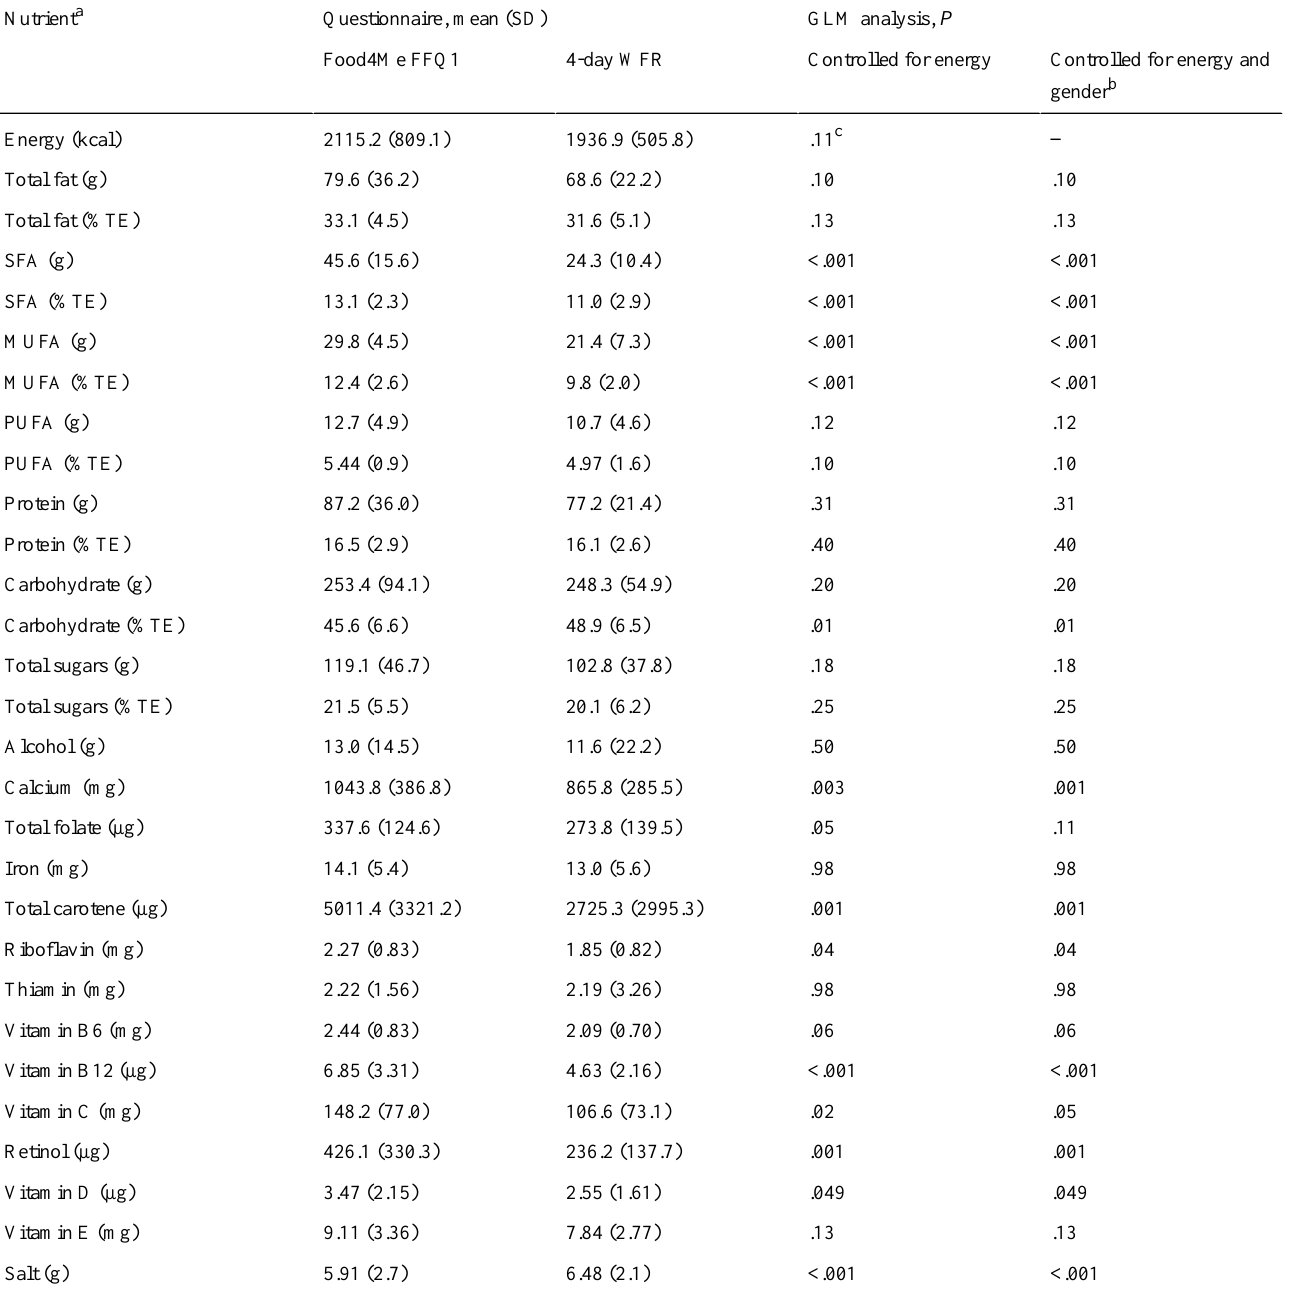
Table 5. Mean daily energy and nutrient intakes estimated by online Food4Me FFQ and 4-day WFR and general linear model (GLM) results (n=49).